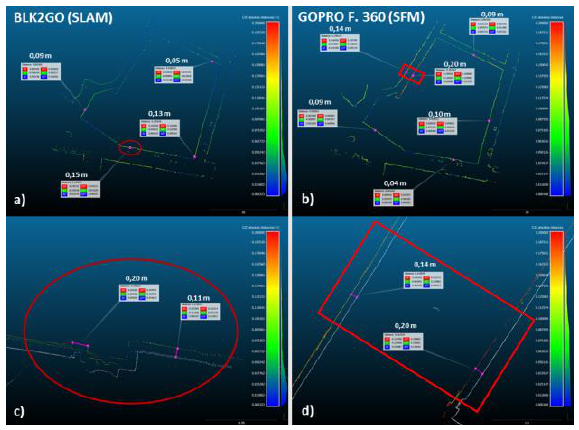
Figure 8 . C2C analyses of horizontal slices for SLAM cloud (a, c) and 360 SFM cloud (b, d). Better viewed digitally.